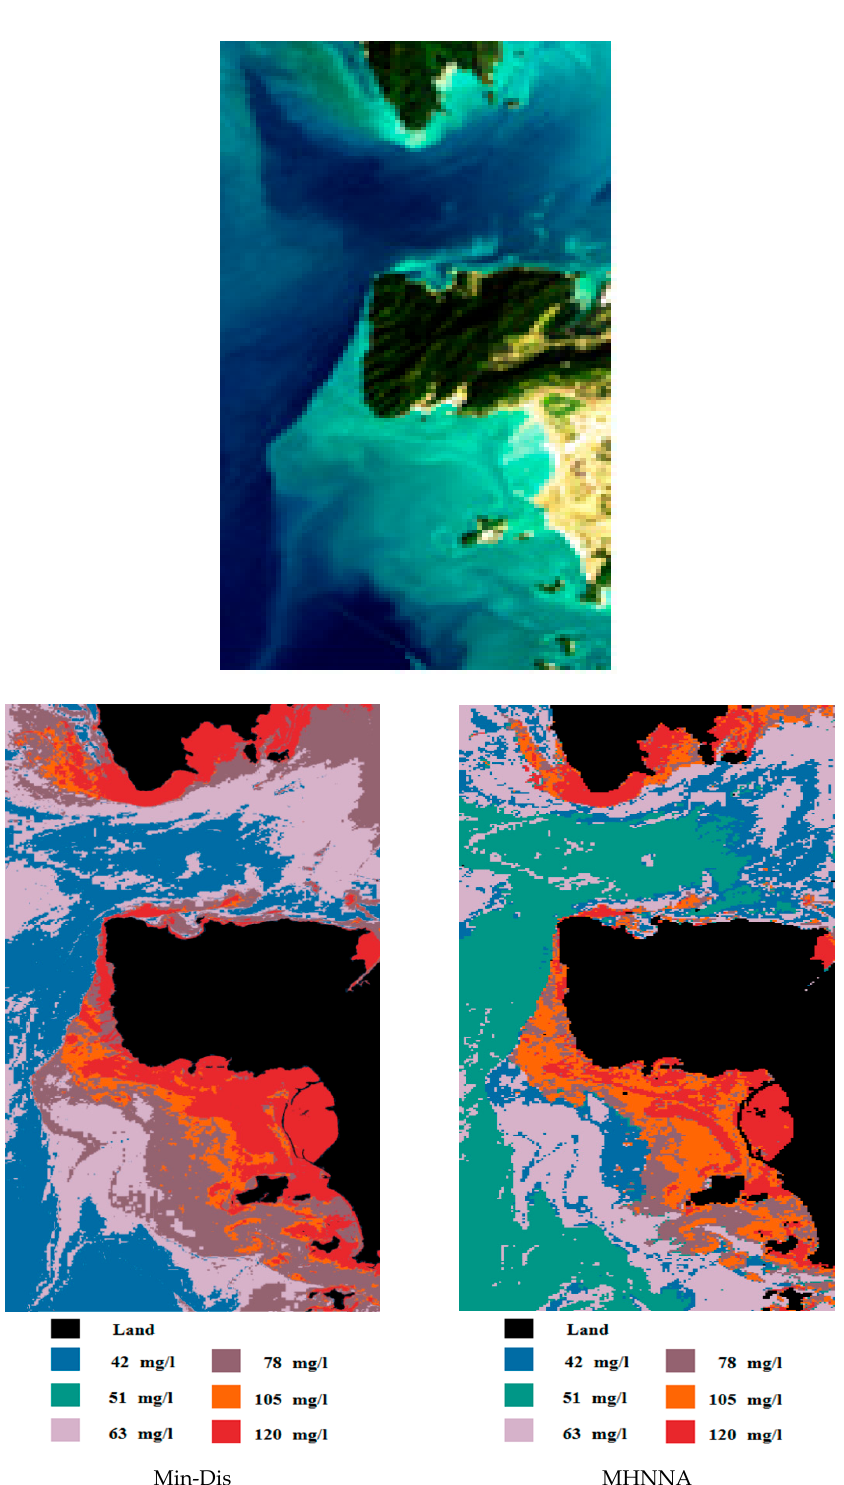
Figure 2. TSS mapping using the MHNNA compared with a Min-Dis classifier using the ALOS 18 January 2010 image.